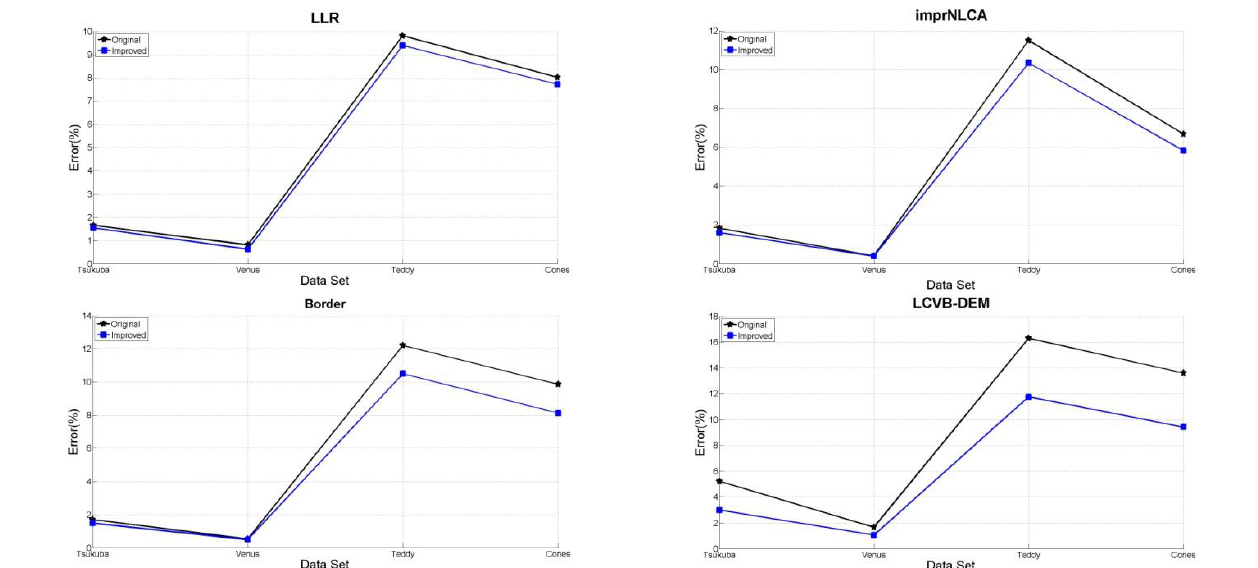
Figure 9. The improvement of start-of-the-art methods on all